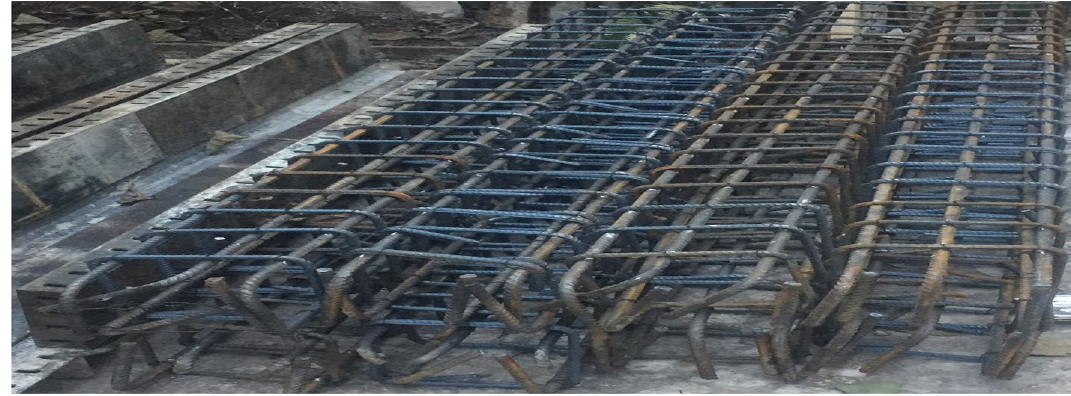
Fig. 2 Corrosion method of rebar